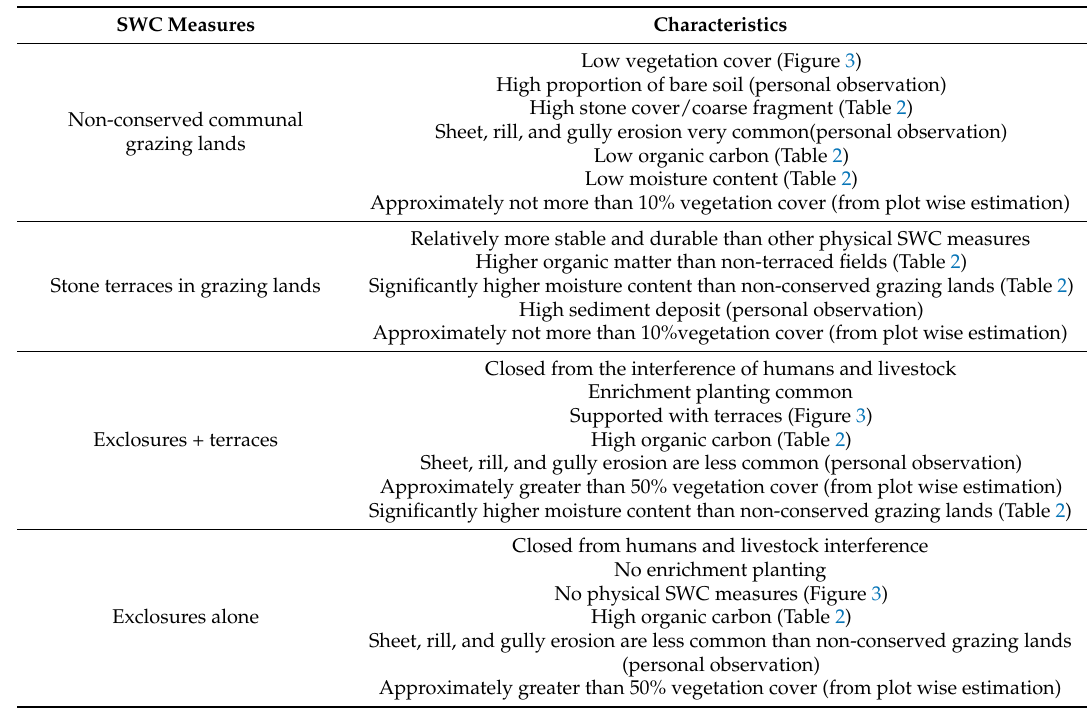
Table 1. Characteristics of the community based SWC measures.